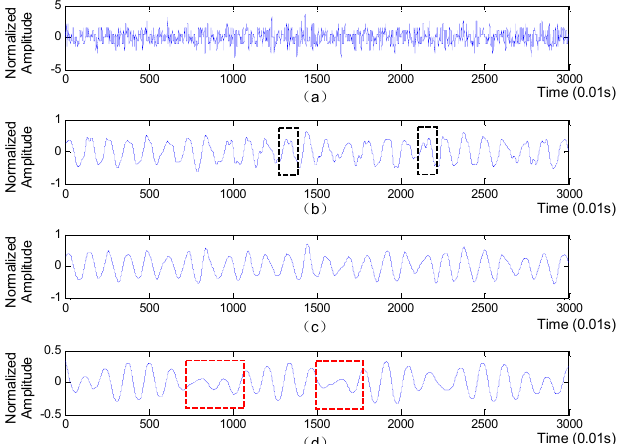
Figure 3. The original BCG and the approximation layers of the BCG. ( a ) The original BCG signal; ( b ) The 4th approximation layer; ( c ) The 5th approximation layer; ( d ) The 6th approximation layer.